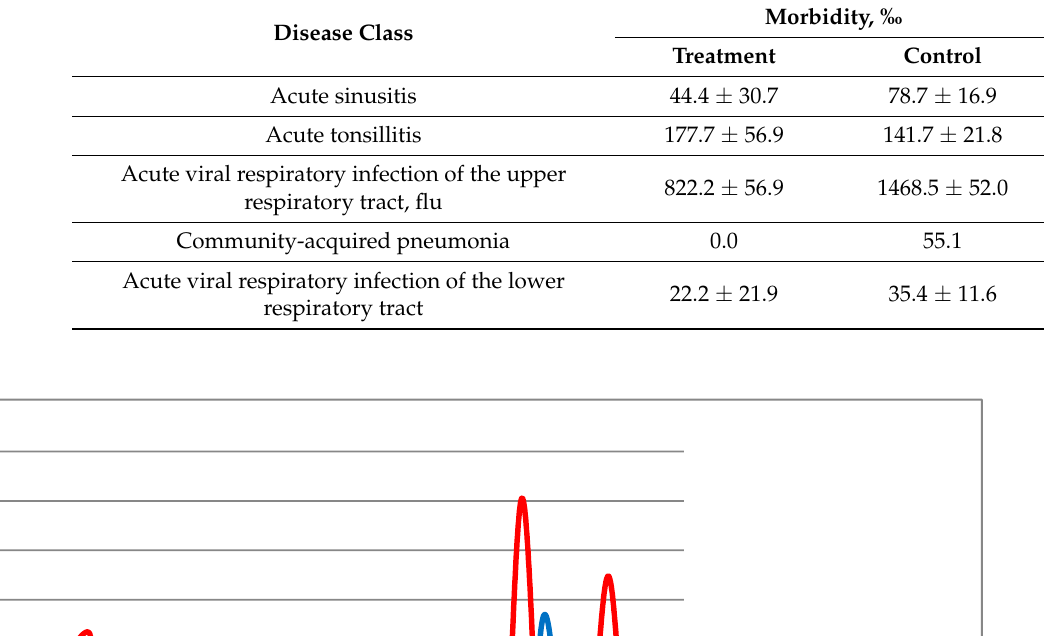
Table 12. Primary incidence of diseases of the respiratory system, М ± m.